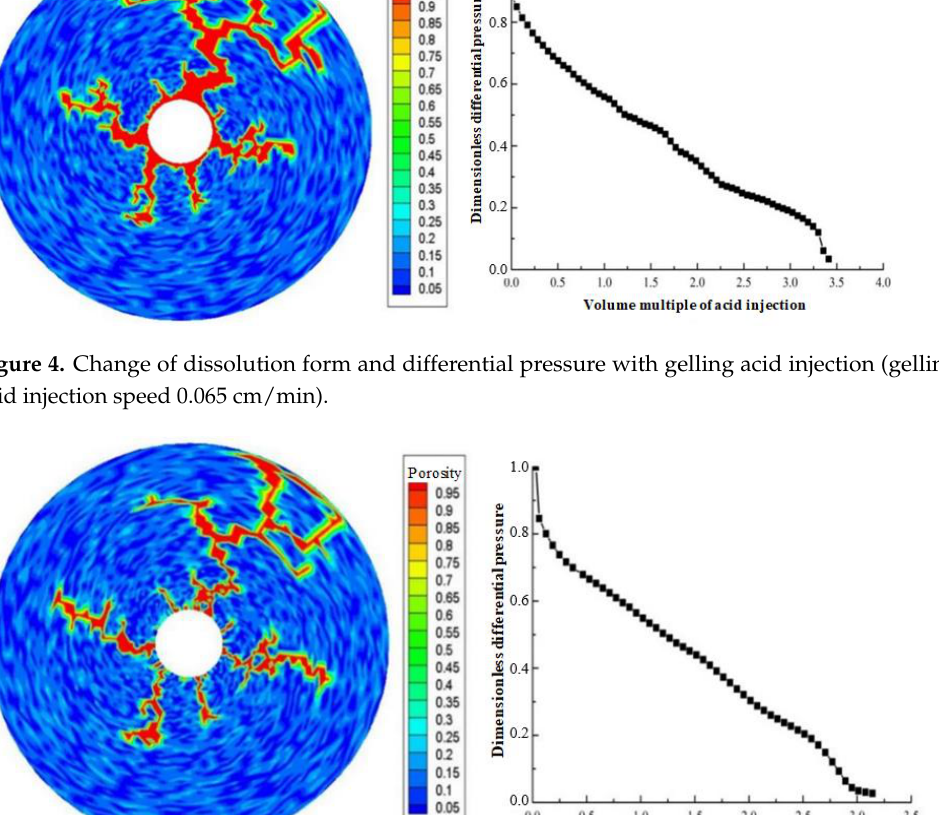
Figure 5. Change of dissolution form and differential pressure with gelling acid injection (gelling acid injection speed 0.65 cm/min).